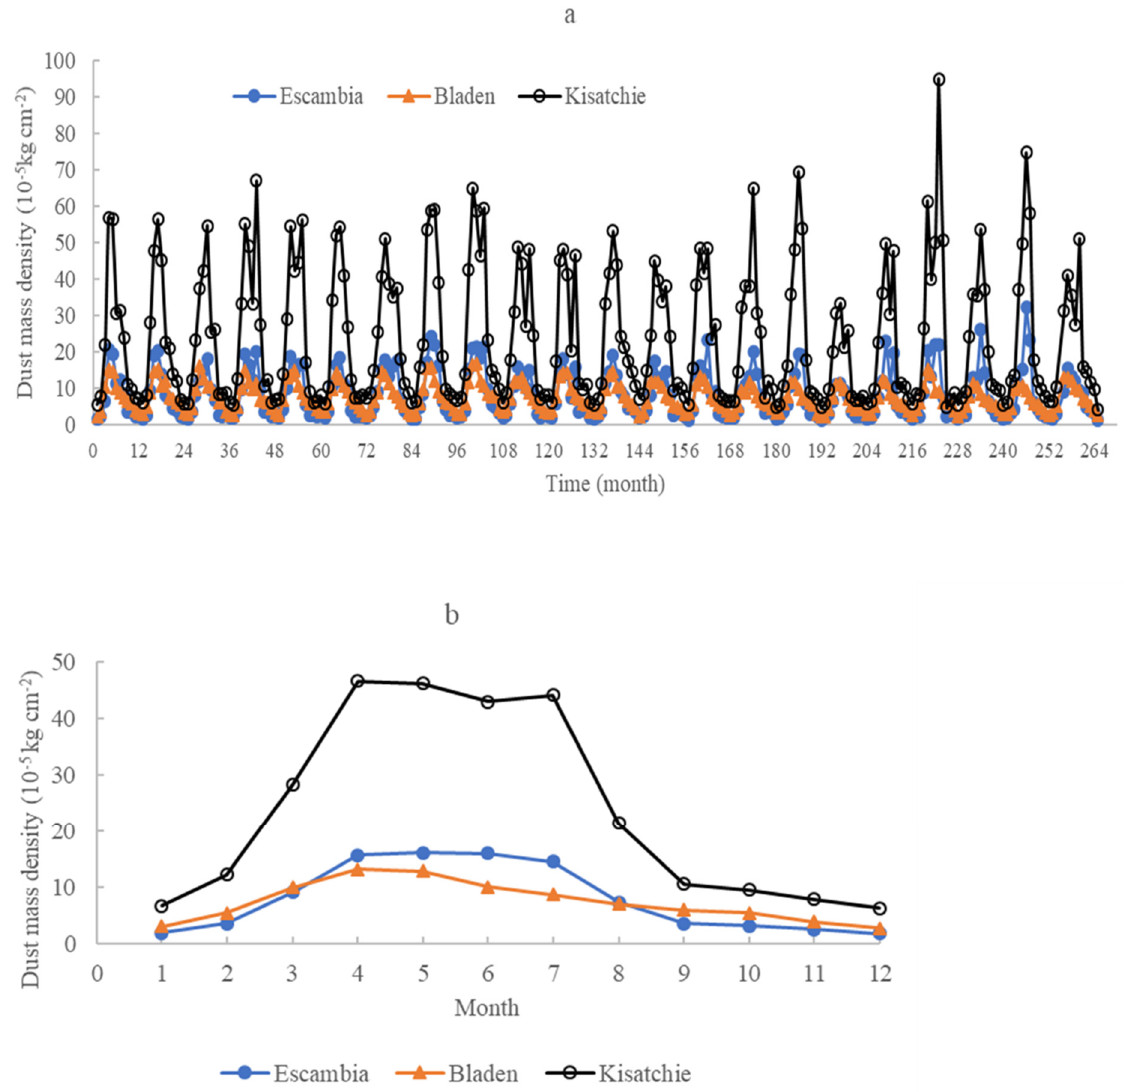
Figure 4. Dynamics of dust column mass density in Escambia, Bladen, and Kisatchie. ( a ) Monthly and yearly dynamics of dust column mass density from January 2000. ( b ) The integrated monthly average of dust column mass density.